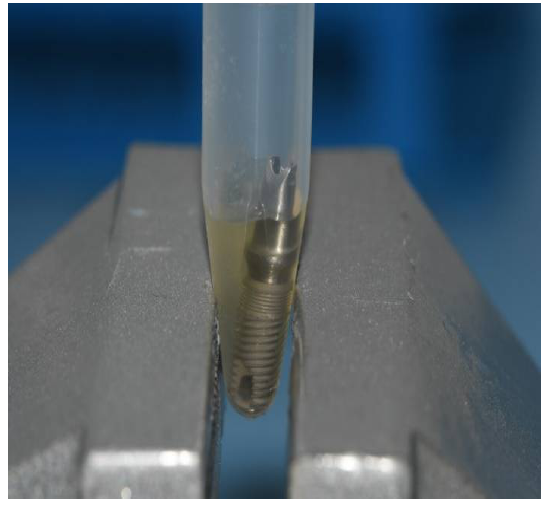
Figure 5. Implant–abutment assembly immersed in bacterial and fungal joint